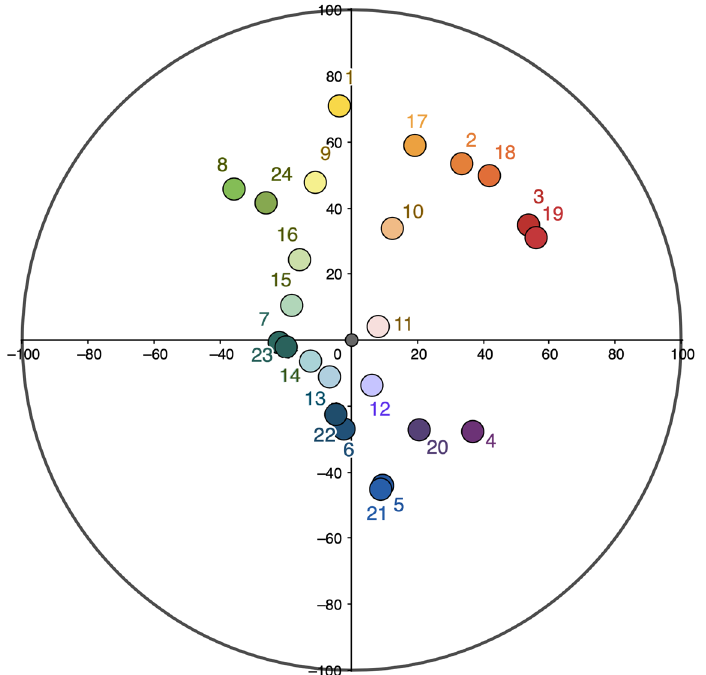
Figure 4. Hue (h°) and chroma (C) of the main colors of the charts from Sections I–III of the Reference Book ; projection into the CIELCh color circle.